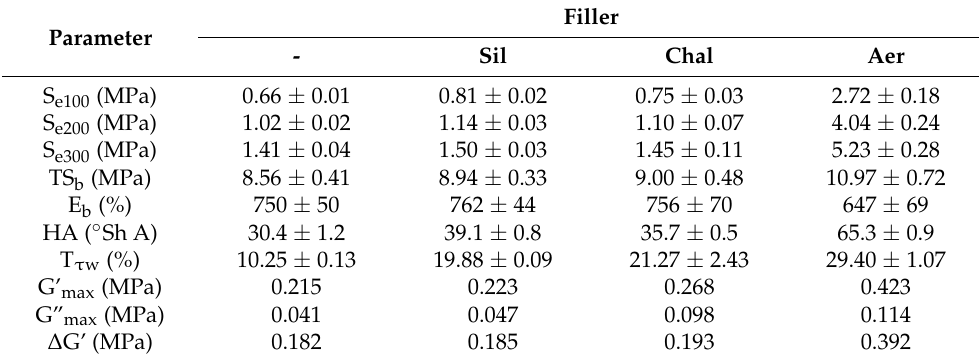
Table 3. The mechanical–dynamical properties of the unfilled or filled vulcanizates, T = 160 ◦ C, t = 30 min.